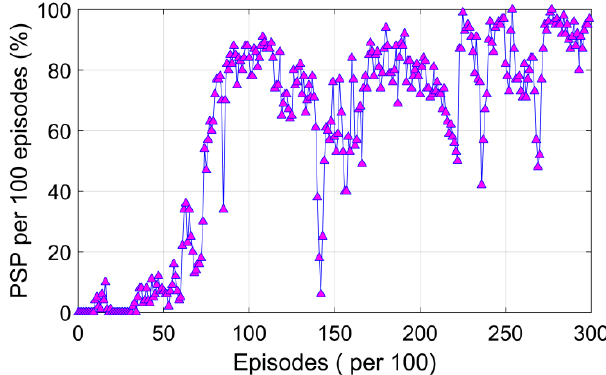
Figure 11. The pursuit success percentage per 100 episodes during the training.